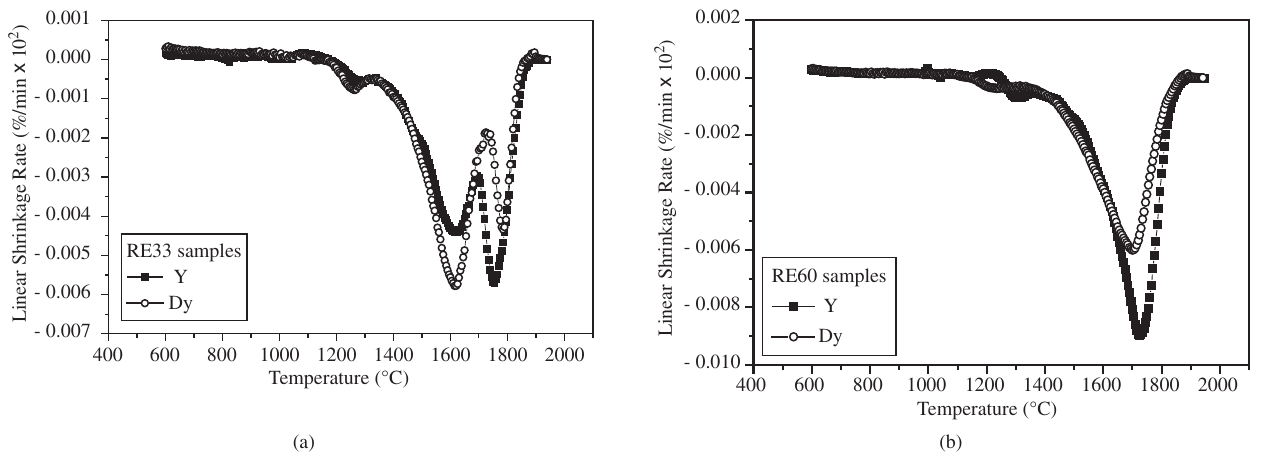
Figure 6. Dilatometric results: linear shrinkage rate versus temperature for several compositions: a) RE 33 samples (RE = Y, Dy); b) RE 60 samples (RE =Y, Dy).